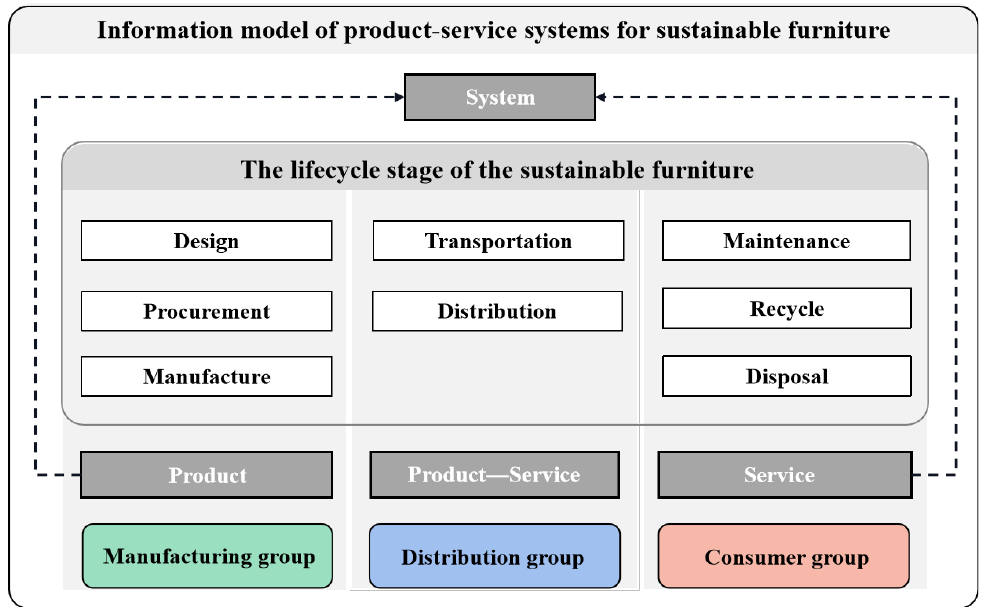
Figure 7. Sustainable furniture PSSs IM in this study (generated by authors).